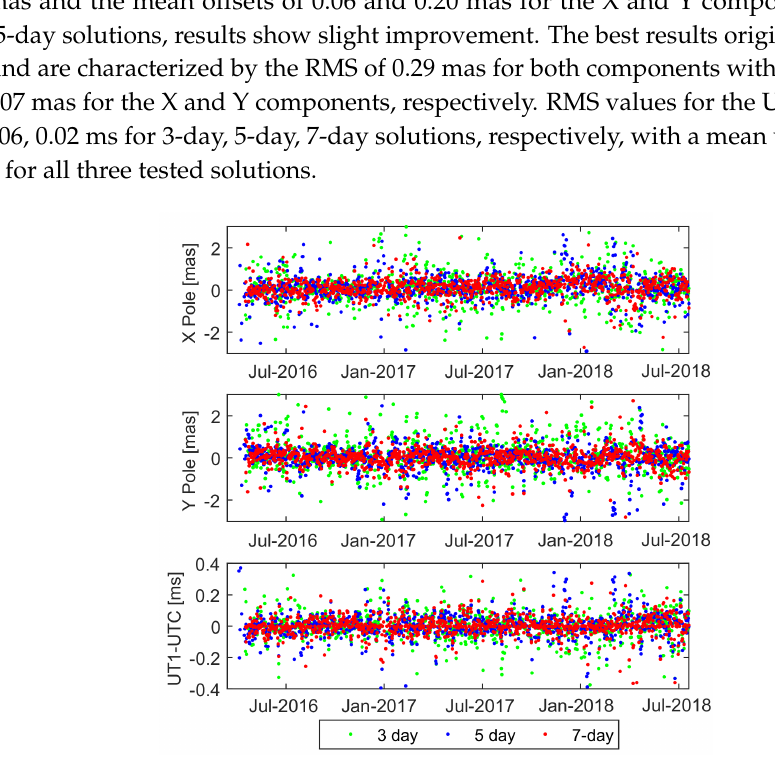
Figure 10. Pole coordinates and the UT1-UTC from S3A/B w.r.t the IERS-14-C04 series for the tests using 3-day (green), 5-day (blue), and 7-day (red)